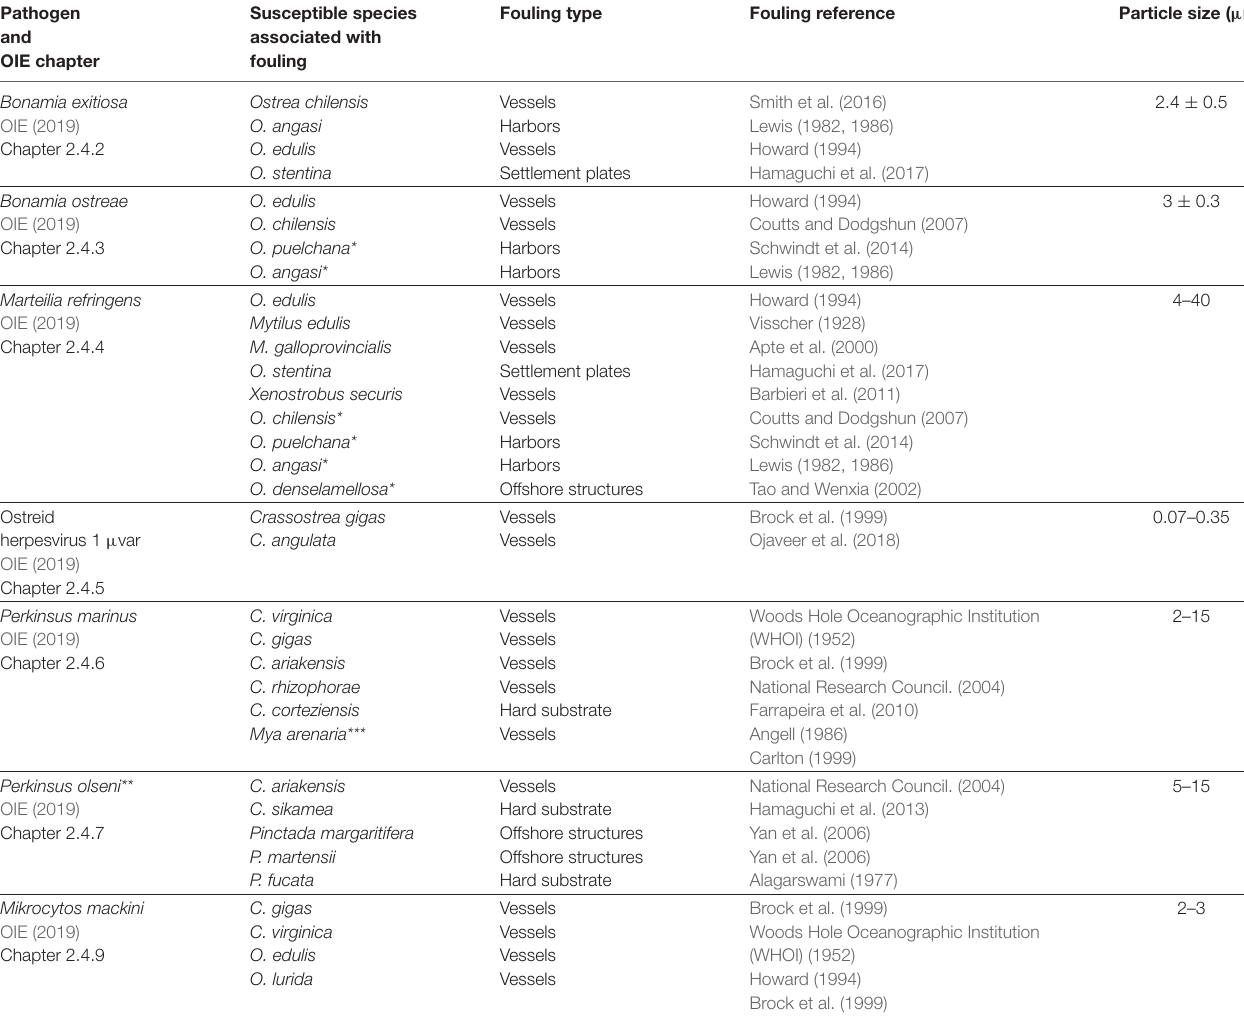
TABLE 1 | OIE-listed molluscan pathogens associated with known fouling species and their size (Bower, 2017; OIE,